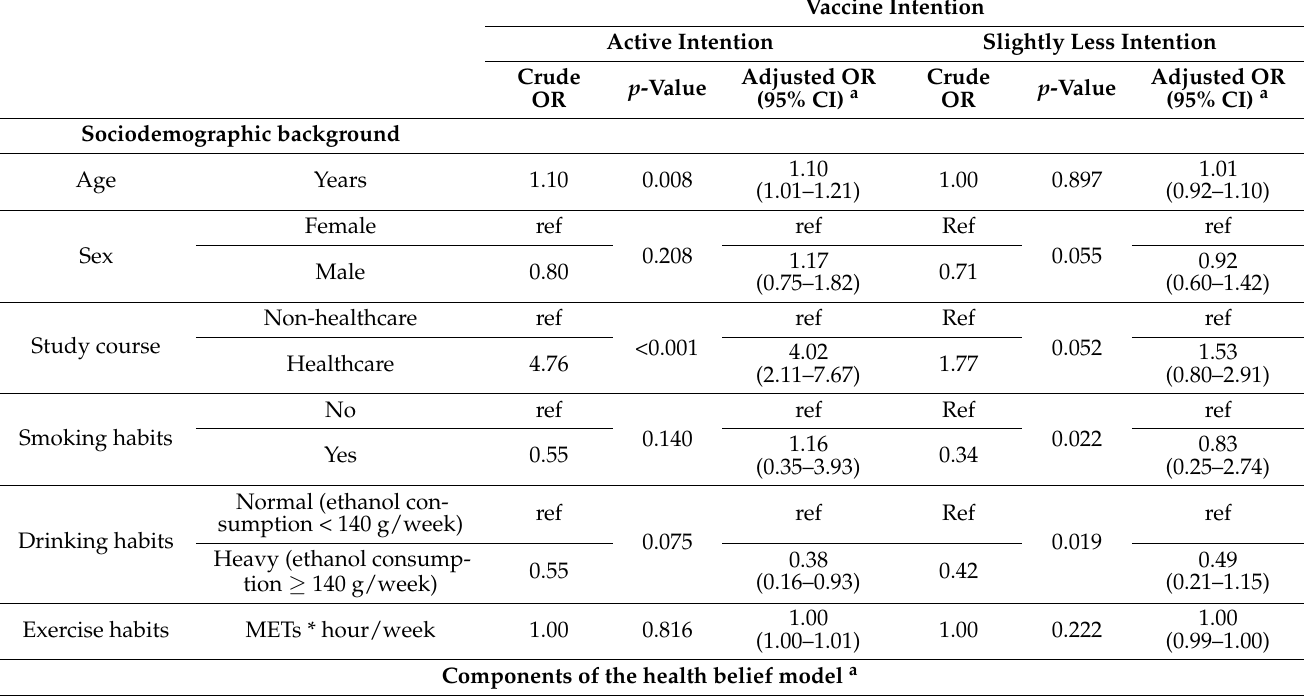
Table 2. Logistic regression analyses of vaccine